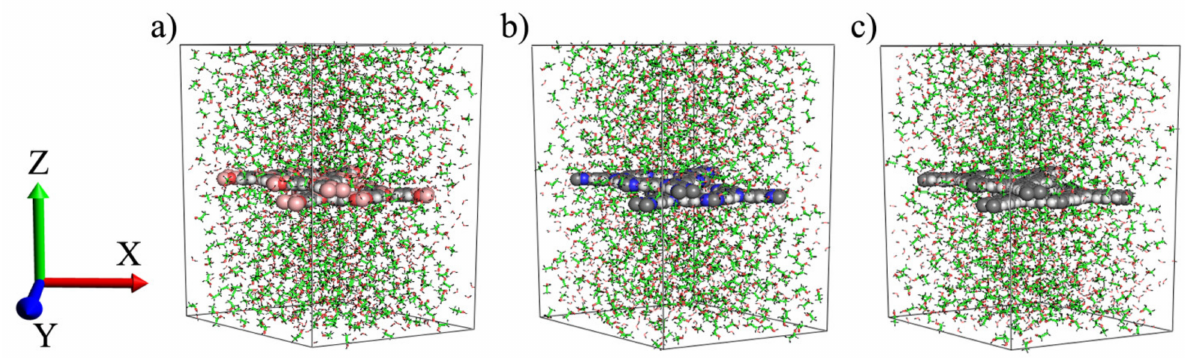
Figure 7. Final configuration of ( a ) COF-1, ( b ) CTF-1 and ( c )